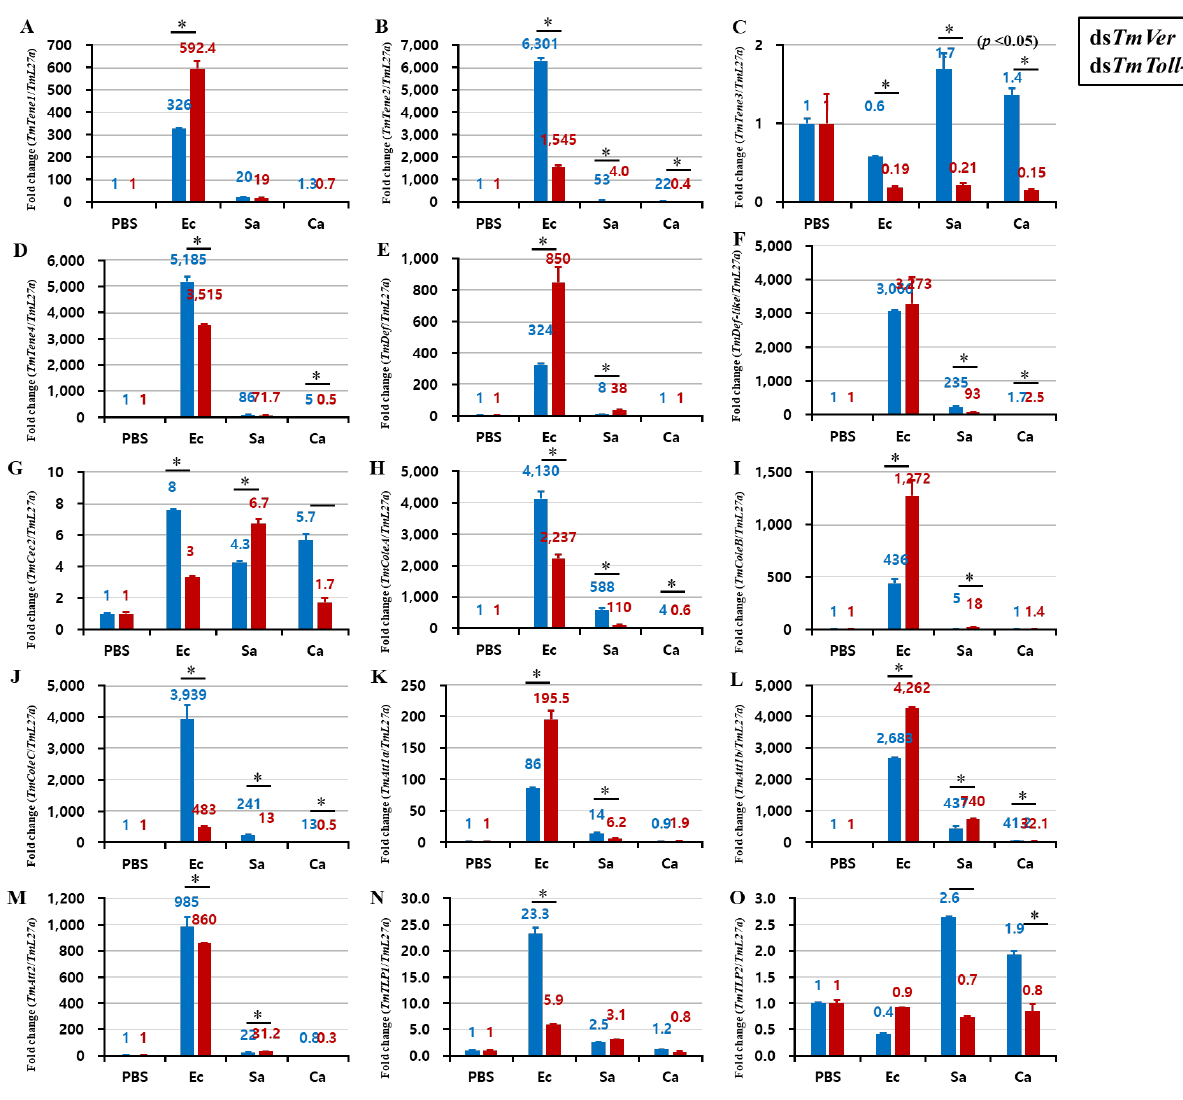
Figure 6. Effect of TmToll-2 RNAi on the induction of 15 AMP genes in the gut of T. molitor larvae infected with E. coli (Ec), S. aureus (Sa), and C. albicans (Ca) by using PBS as the control. At 24 h post microbial injection, AMP genes, including TmTene1 ( A ), TmTene2 ( B ), TmTene3 ( C ), TmTene4 ( D ), TmDef ( E ), TmDef-like ( F ), TmCec2 ( G ), TmColeA ( H ), TmColeB ( I ), TmColeC ( J ), TmAtt1a ( K ), TmAtt1b ( L ), TmAtt2 ( M ), TmTLP1 ( N ), and TmTLP2 ( O ) were examined via qPCR by using ds TmVer as a knockdown control and T. molitor ribosomal protein ( TmL27a ) as an internal control. All experiments were performed in triplicate. Asterisks indicate significant differences between ds TmToll-2 - and ds TmVer RNAi-treated groups determined by Student’s t -test ( p < 0.05).